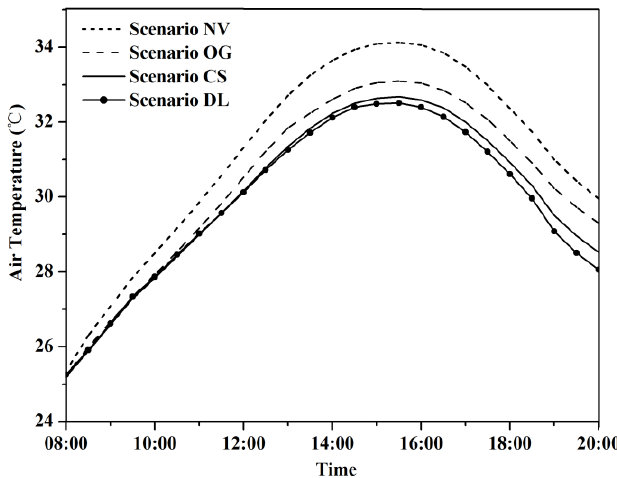
Figure 5. Comparison of average hourly air temperature at 1.5 m above ground. NV, OG, CS and DL are short for No Vegetation, Only Grass, Current Situation and Double LAD respectively.